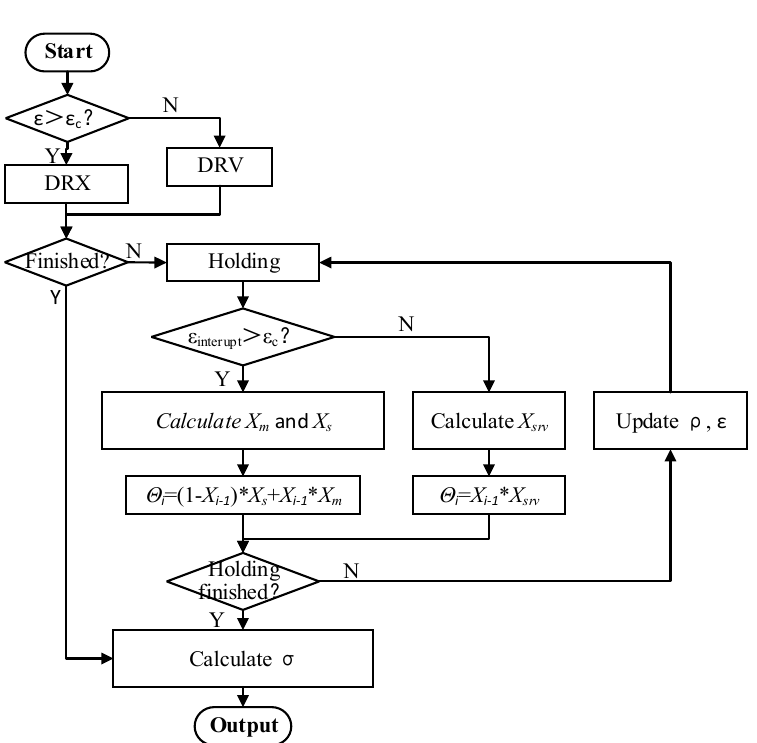
Figure 7. Calculation procedure of the flow-stress.